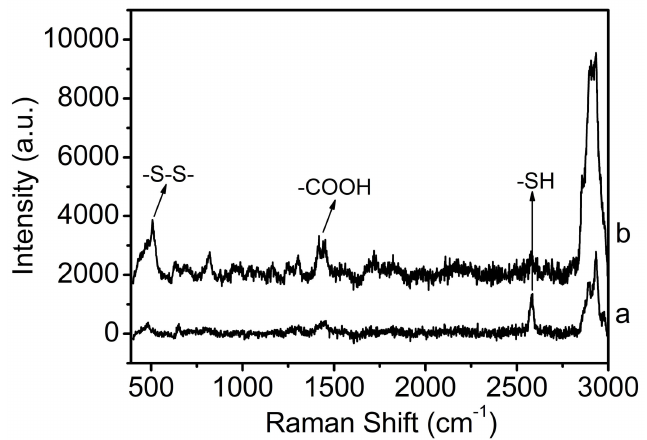
Figure 4. Raman spectra of MSNs-SH ( a ) and MSNs-SS-DMSA ( b ).